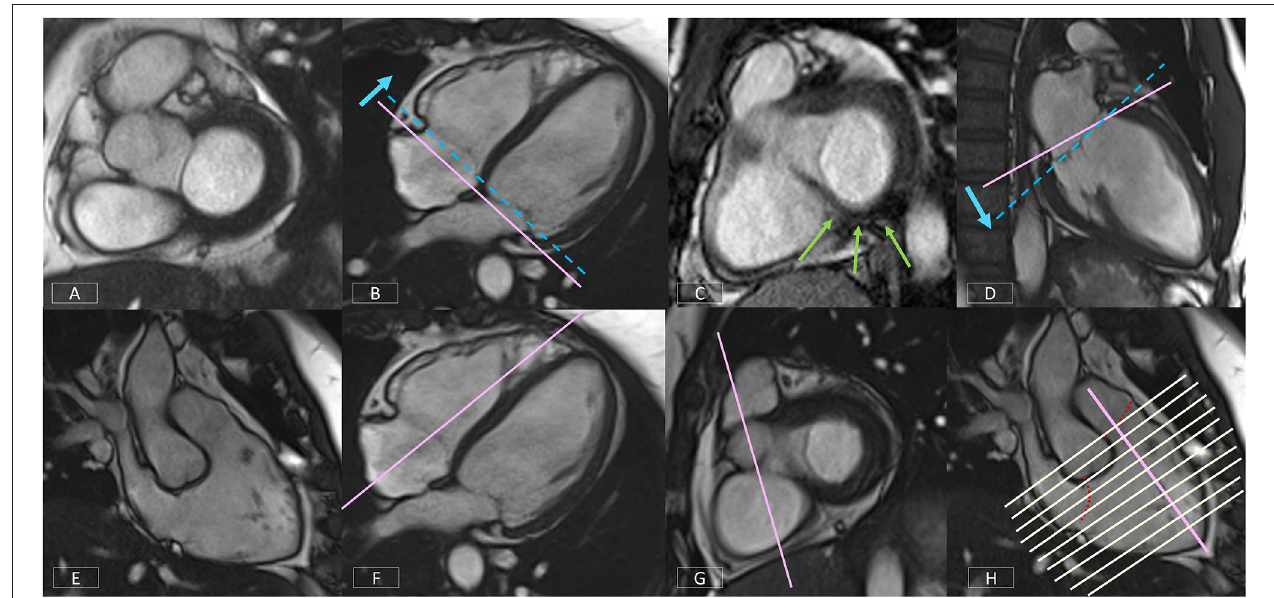
FIGURE 10 | Top row: Positioning corrections for the LV SAX series include repositioning the slice more apically (B) if the basal diastolic phase slice includes atrium (A) . If there is an inconsistent amount of myocardium around the blood pool (C) , the slice angle is tilted on the LV VLA view (D) . Bottom row: A well-positioned RV VLA (E) is achieved by positioning the slice on the 4-chamber view (F) through the RV apex and avoiding the septum, then tilting the slice plane up to the RVOT and pulmonary valve on the basal LV SAX slice (G) . The RV SAX series can then be planned on this view to transect the tricuspid valve at an angle between 45 ◦ and 90 ◦ (H)